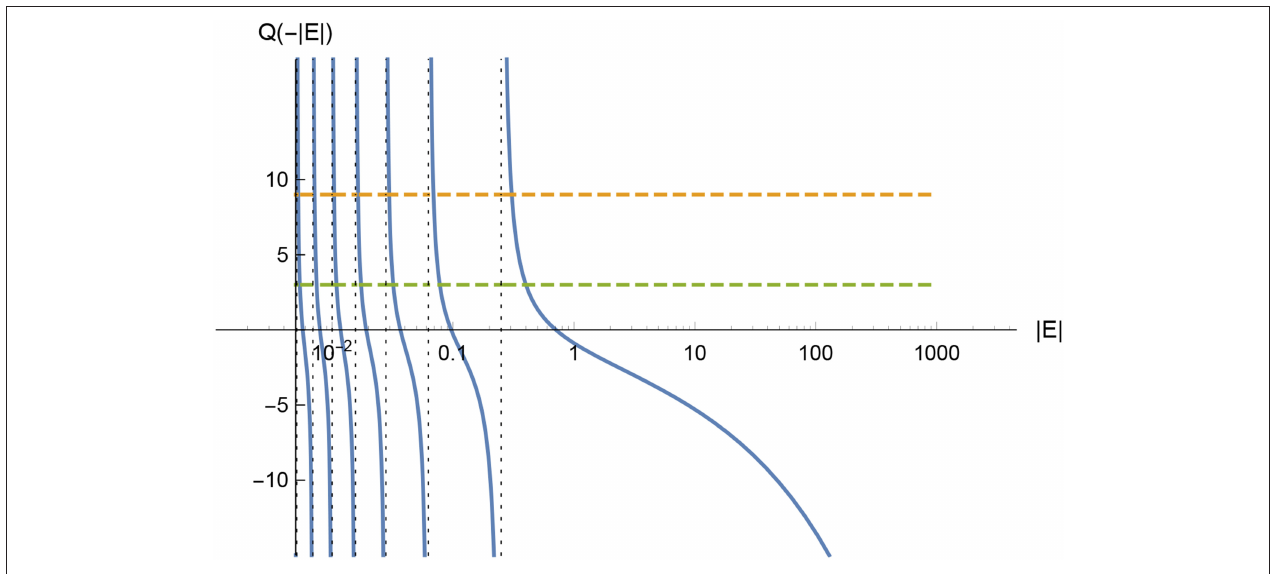
γ 2 , n 1,2,3, , for which 4 n 2 = − = ···